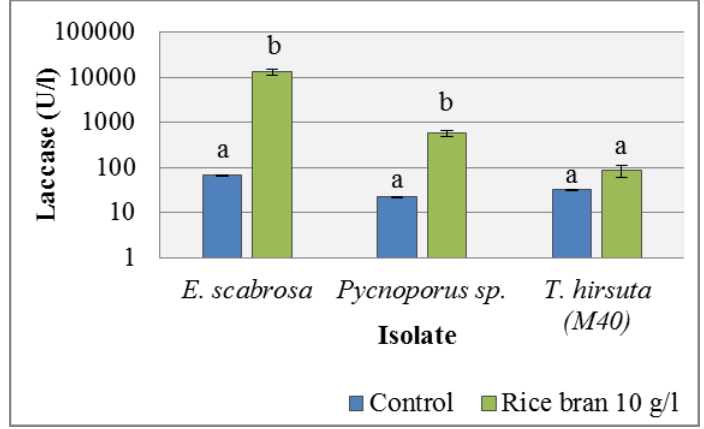
Figure 5: Production of laccase by the three selected basidiomycetes with and without rice bran. Note that the y axis is on a logarithmic scale. Error bars indicate standard errors of the means of triplicates. For individual isolates, values not sharing the same letter are significantly